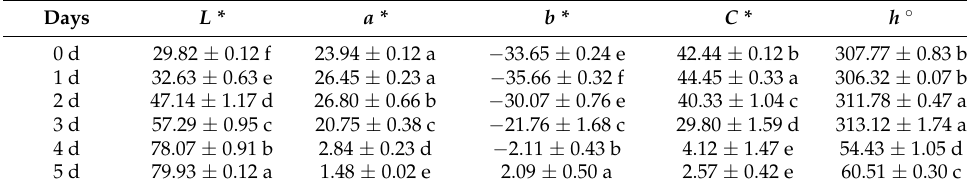
Figure 2. The total content of anthocyanin in B. acuminata petals. ( A ) The petals after opening in B. acuminata . ( B ) Total content of anthocyanin. Means with different letters (a,b,c,d,e) are significantly different from each other ( p < 0.05). Table 1. Measurement data of B. acuminata flower